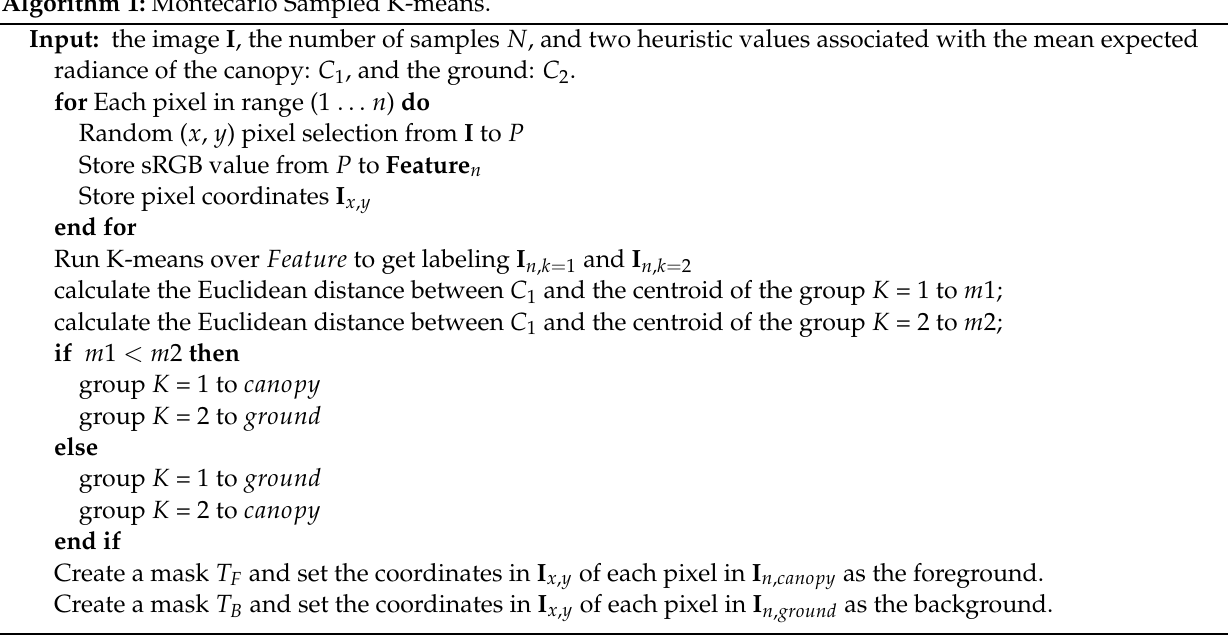
Algorithm 1: Montecarlo Sampled